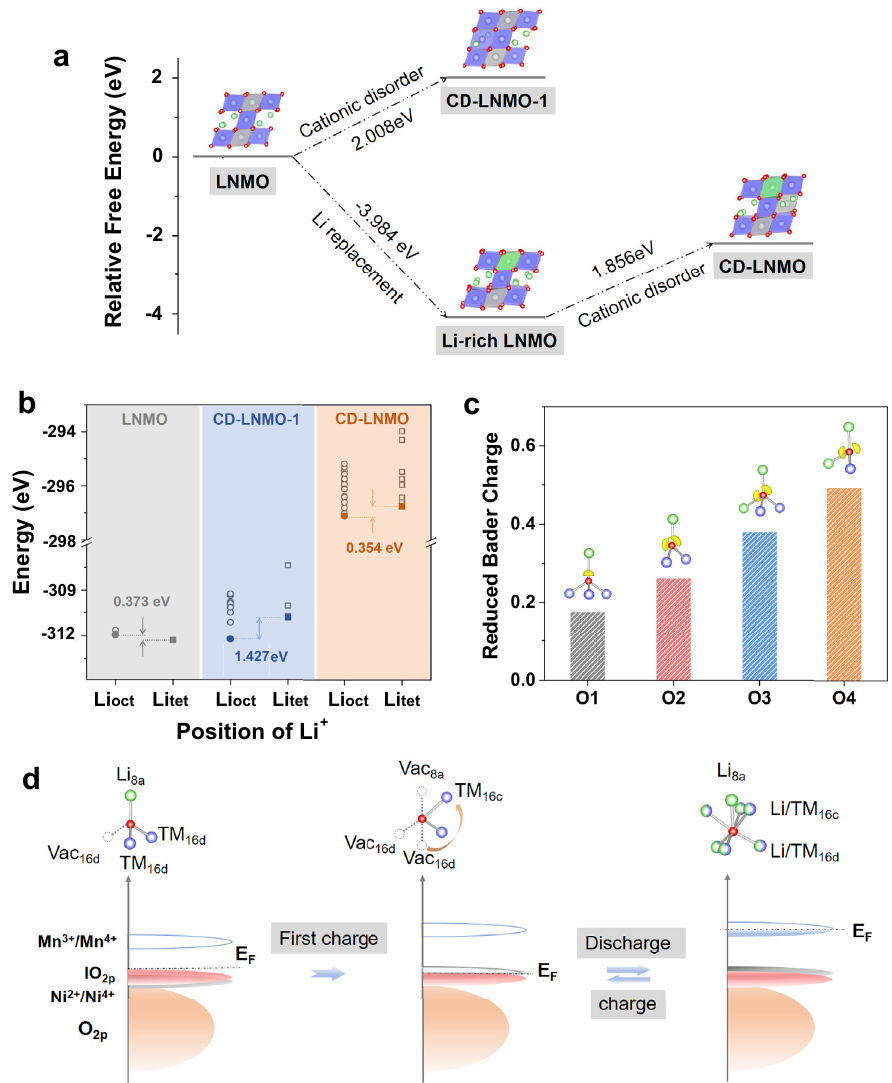
Fig. 7 | Understanding the physicochemical properties of lithium-rich layered oxide materials via atomistic calculations. a Calculated free energy diagrams of the structural evolution on LNMO. The ligands LiO 6 , MnO 6 , and NiO 6 are repre- sented by green, blue, and gray octahedrons, respectively. The free energy values were calculated based on the total supercell. b The energy difference between the octahedral sites (Li oct ) and tetrahedral sites (Li tet ) in LNMO, CD-LNMO-1, and CD- LNMO. c The reduced Bader charges of oxygen ions under different conditions of thefullydelithiatedCD-LNMO.TheinsetsshowthecalculatedELF(isovaluesof0.7)